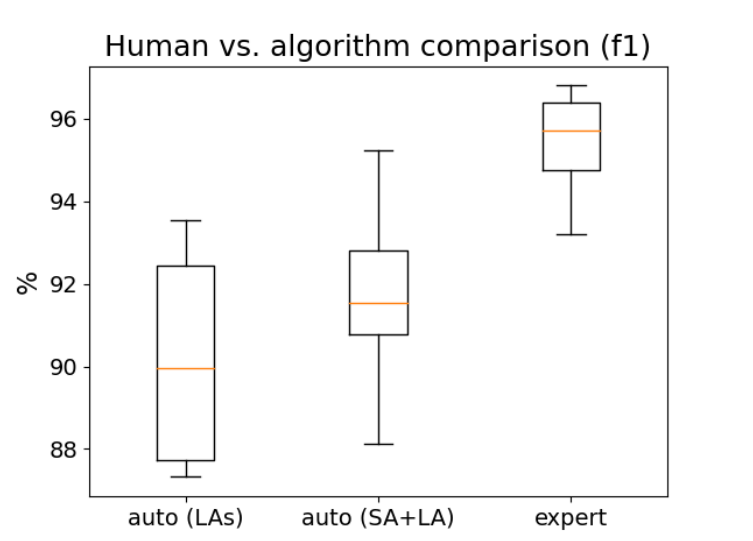
Figure 5. Comparison of the human (expert) and algorithm (auto) performances. The p -value between auto (LA) and auto (SA+LA) is lower than 0.001, which means using the short-axis images contributed to a significantly better performance. Between the auto (SA+LA) and expert group, the p -value was less than 0.001. For calculating the p -values, we used two-sample t